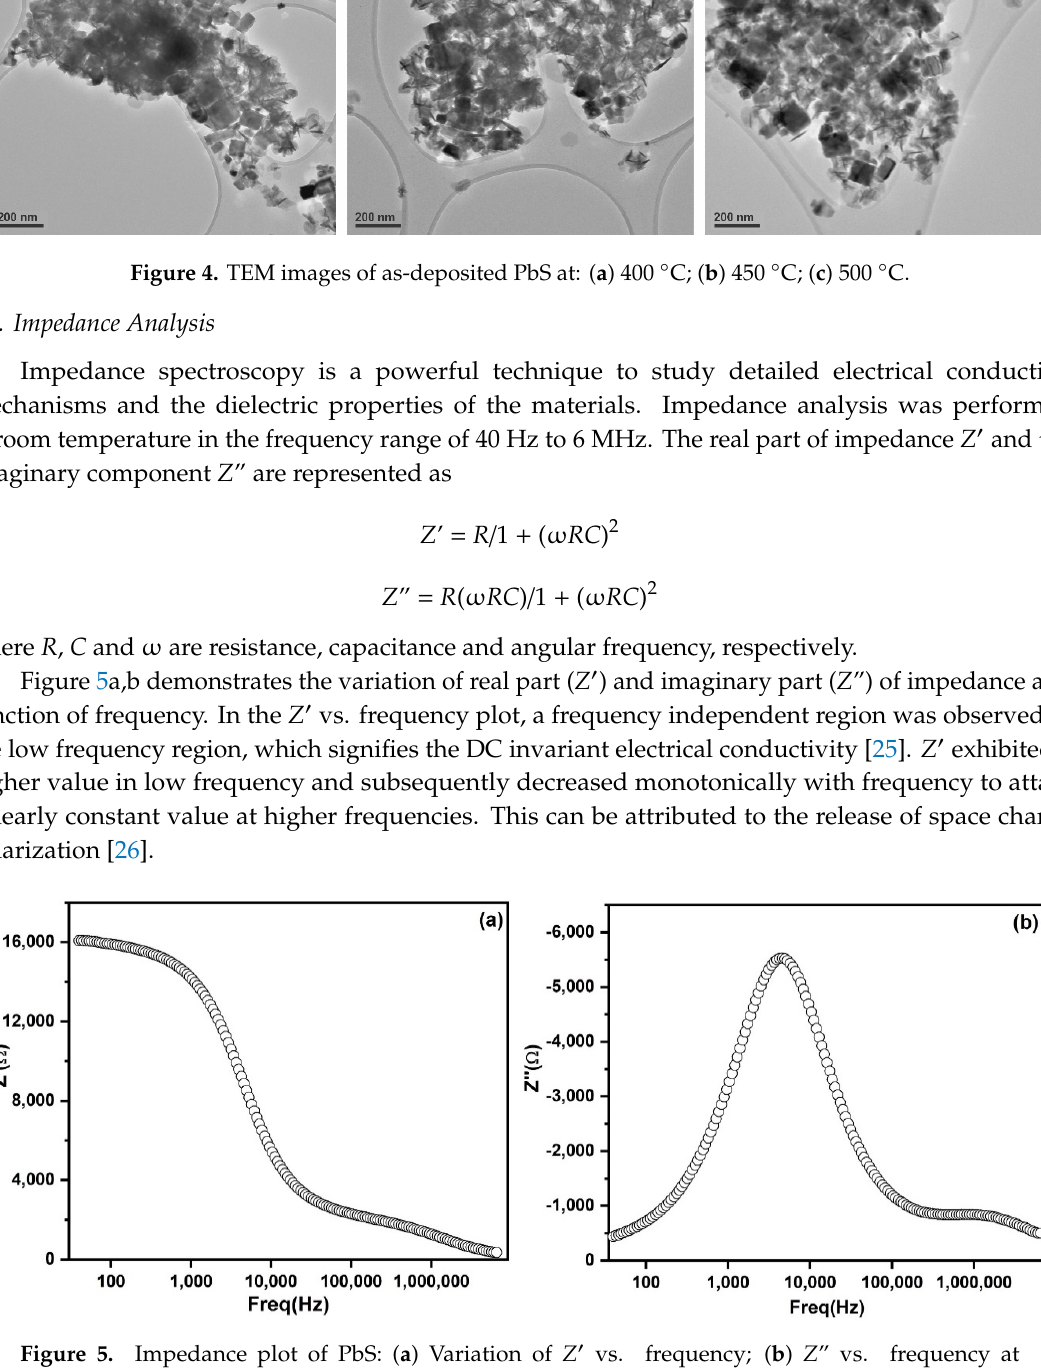
Figure 5. Impedance plot of PbS: ( a ) Variation of Z ′ vs. frequency; ( b ) Z ′′ vs. frequency at room temperature.